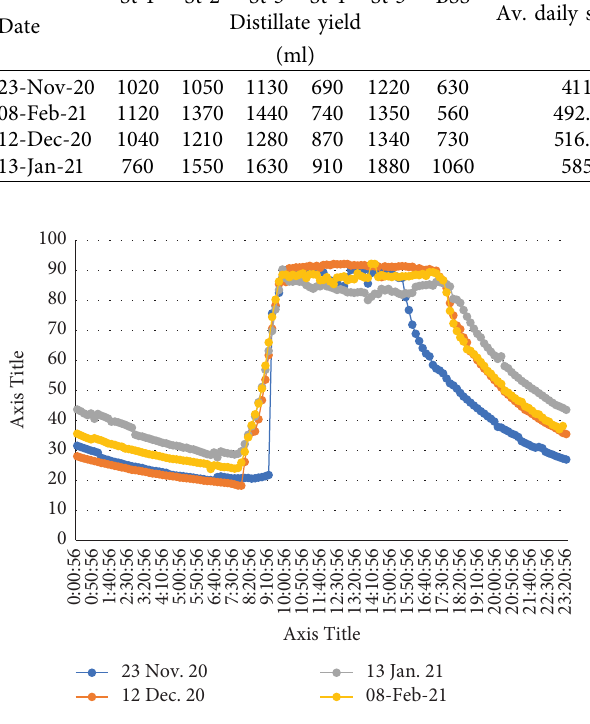
Figure 11: Evaporator SW temperature on various days under high average solar radiation.